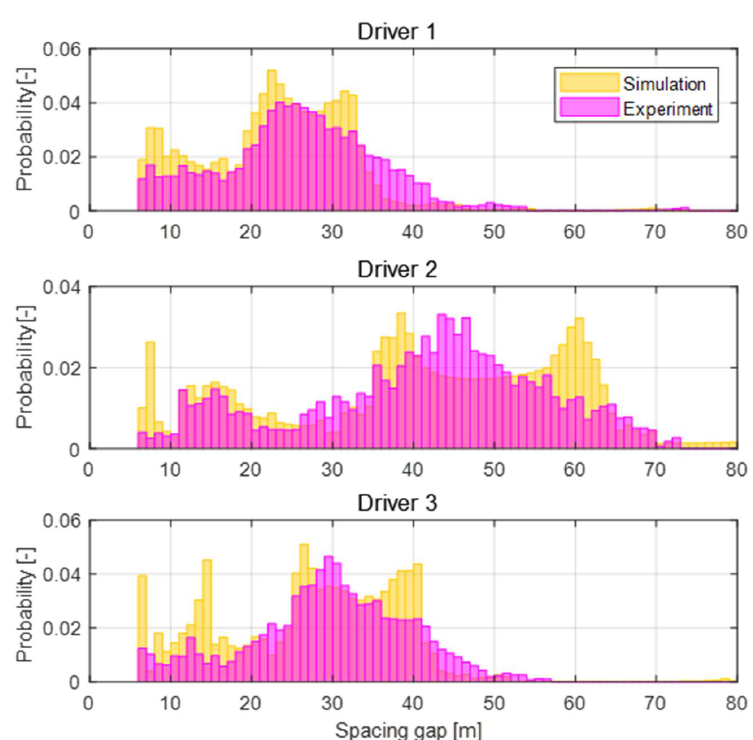
Figure 15. Spacing gap distributions of driving data and proposed algorithm results by each driver.